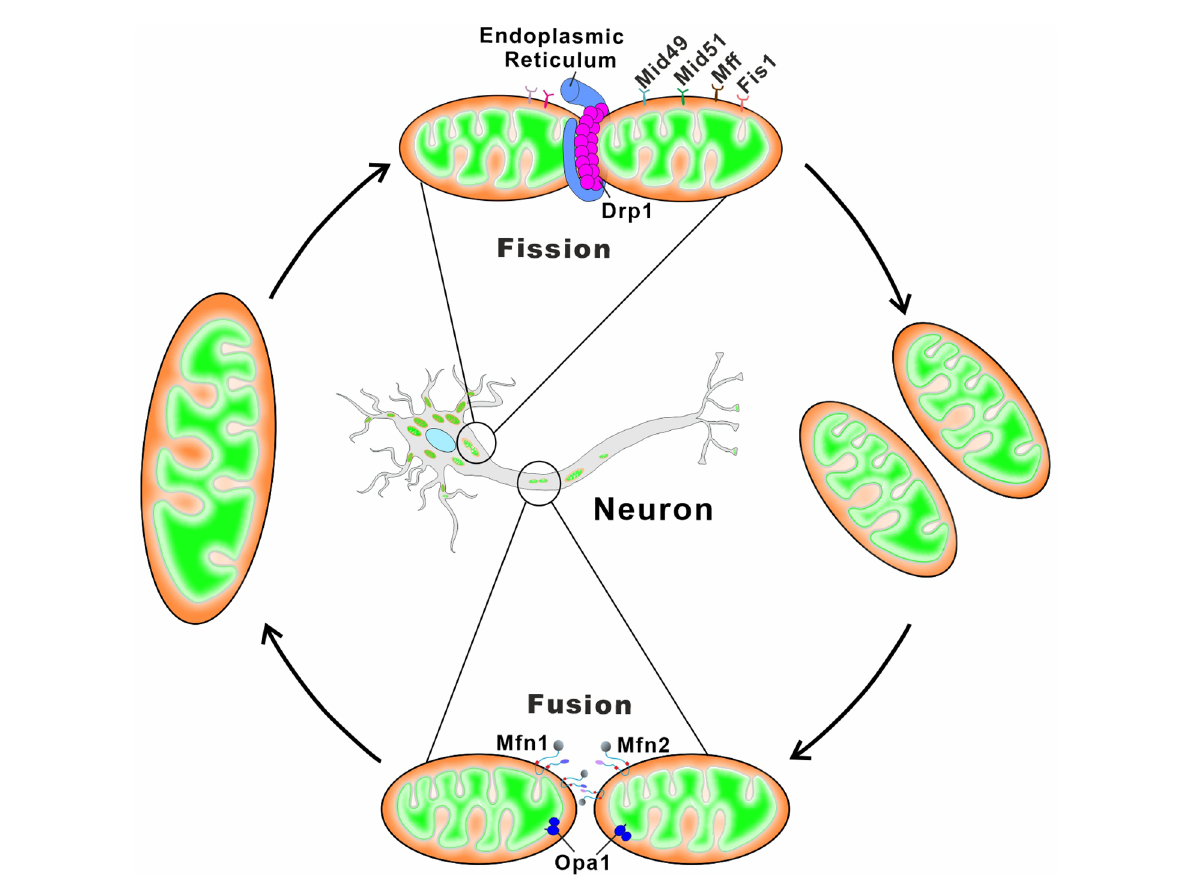
FIGURE3 Schematic depiction of mitochondrial fusion and fission in neurons. Mitochondrial fusion relies on membrane proteins Mfn1/2 and OPA1 residing in the OMM and the IMM, respectively. Mfn1 and Mfn2 form homo-oligomeric (Mfn1-Mfn1 or Mfn2-Mfn2) and hetero-oligomeric (Mfn1-Mfn2) complexes in trans between the opposing mitochondria to induce the OMM fusion. The long and short forms of OPA1 synergistically catalyze the tethering and fusion of the IMM. Mitochondrial fission begins with the ER contacts with the OMM at the ER-mitochondria contact sites, and ER wraps tightly around the mitochondria to form constrictions. The cytosolic Drp1 is subsequently recruited to the OMM via multiple membrane adaptors MiD51, MiD49, Fis1, and Mff. Drp1 oligomerizes at the ER-marked pre-constriction sites, forming a ring-like structure around the mitochondria for further membrane